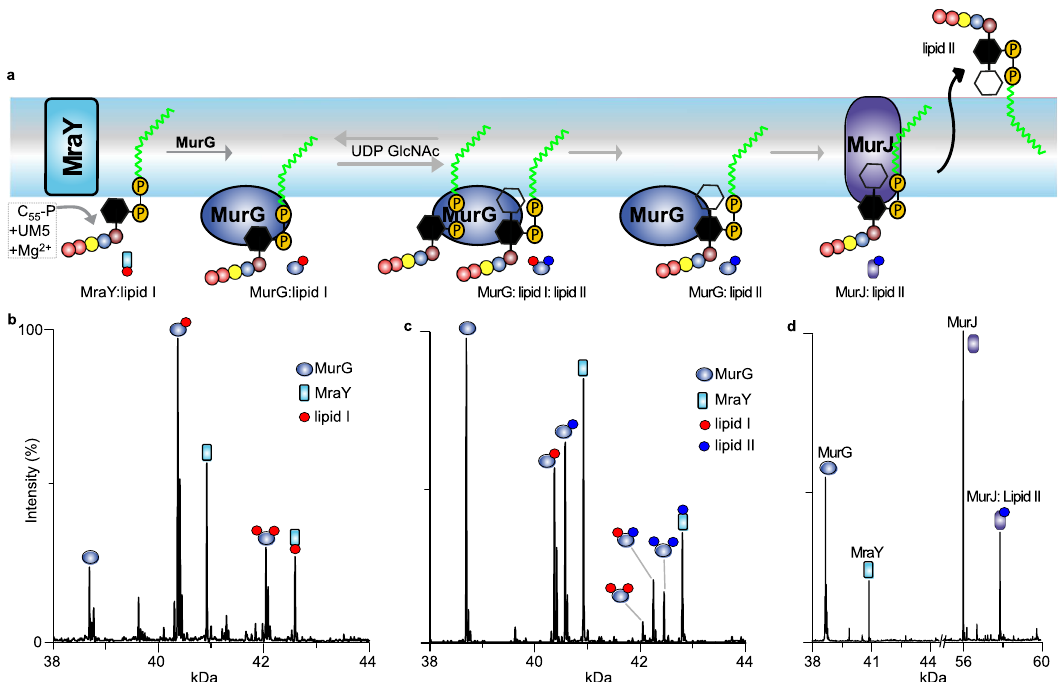
Fig. 5 Coupled synthesis of lipid II by MraY and MurG and its passage to MurJ. a Schematic illustrations showing the steps involved in the coordinated synthesis of lipid II and its passage to the fl ippase MurJ. For simplicity, MraY is shown here as monomeric. b Deconvoluted mass spectrum of MurG included in a lipid I synthesis reaction (MraY incubated with Mg 2 + , C 55 -P and UM5). MurG forms 1:1 and 1:2 stoichiometric complexes with synthesised lipid I and binds lipid I with higher af fi nity than MraY, even though MraY is in threefold molar excess. c Deconvoluted mass spectrum capturing the coupled synthesis of lipid I and lipid II following incubation of MurG and UDP-GlcNAc with MraY, Mg 2 + , C 55 -P and UM5. Both lipid I and lipid II (synthesised during the reaction) bind to MurG but only lipid II forms adducts with MraY under these conditions. d Competition amongst MurG, MraY and MurJ for lipid II, the latter being synthesised in situ following incubation of MurG and MraY with UDP-GlcNAc, Mg 2 + , C 55 -P and UM5 prior to addition of MurJ. The fact that MurJ binds all available lipid II indicates that the MurJ fl ippase has a higher af fi nity for lipid II than either MurG or MraY. Spectra were obtained under the same conditions by releasing the protein from LDAO micelles where the three proteins are stable. All reactions were however carried out in a DDM- containing buffer where MraY is an equilibrium of monomer and dimer. Observed masses are listed in Supplementary Table